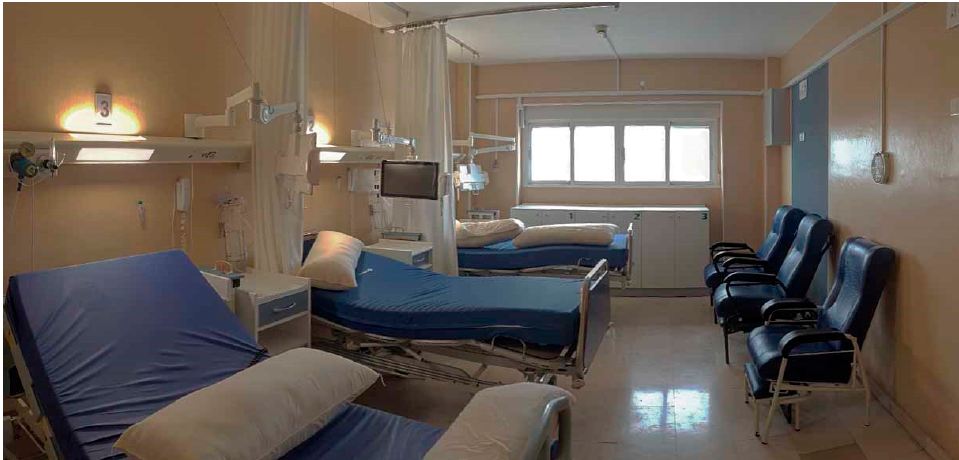
Figure 1. Monitored hospital room. Source: Authors.